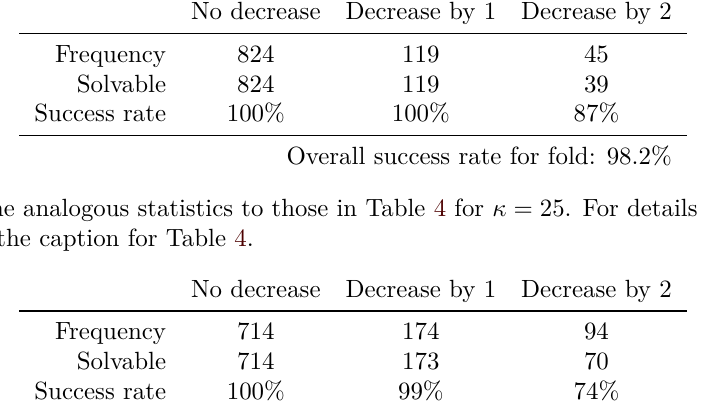
Table 4: A breakdown of the statistics on the 128 to 64 dimensional fold on 1000 Kyber cold boot instances ( κ = 19) when carrying out the three guessing phases. The “Solvable” row indicates how many of the instances in each category are solvable by the three guessing phases.